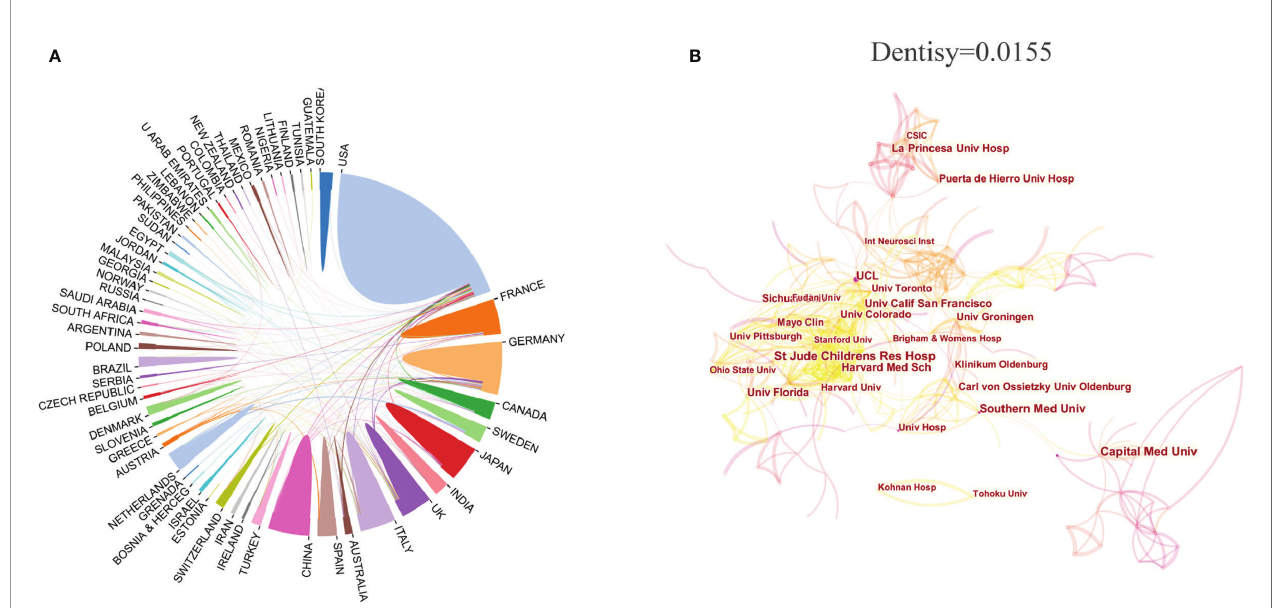
FIGURE 3 | The distribution of countries/regions and institutions. Cooperative relations among countries/regions (A) (The area represents the number of articles, and the connection represents the cooperative relationship. Conducted by online analysis platform of Bibliometrics) and institutions (B) . [Conducted by CiteSpace (version 5.7.R3, Drexel